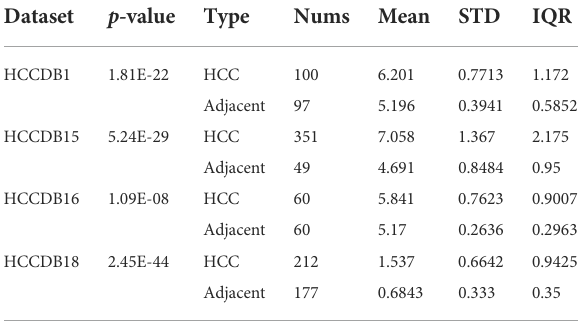
TABLE 1 Differential expression analysis of FANCD2 from clinical cohorts impinged on the HCCDB. Dataset